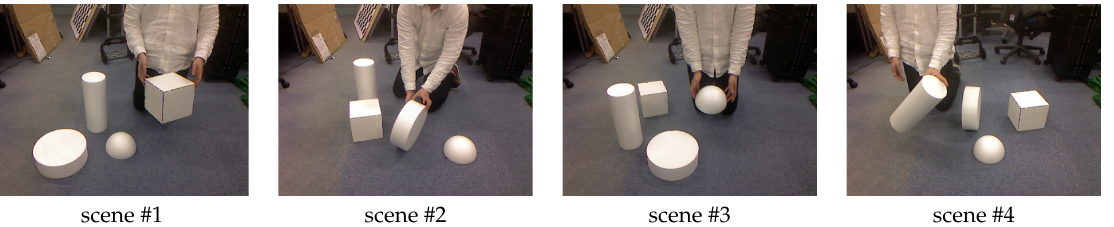
Figure 5. Examples of frames included in the